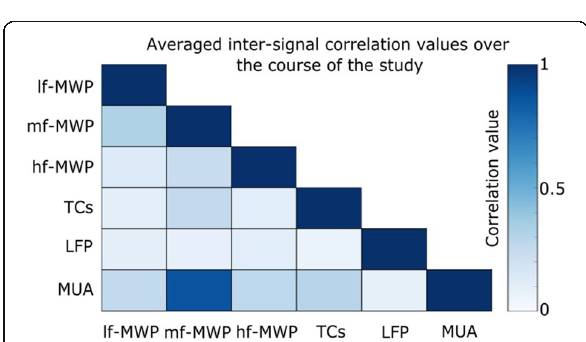
Fig. 7 Averaged inter-signal correlation matrix. Inter-signal temporal correlation time series were averaged to give an overall correlation value for a given paired signal over the course of the study for Task 2 (For more details, please refer to Methods section and also Additional file 1: Figure S1). In general, MUA and mf -MWP features showed a very high level of correlation, with an average correlation value of